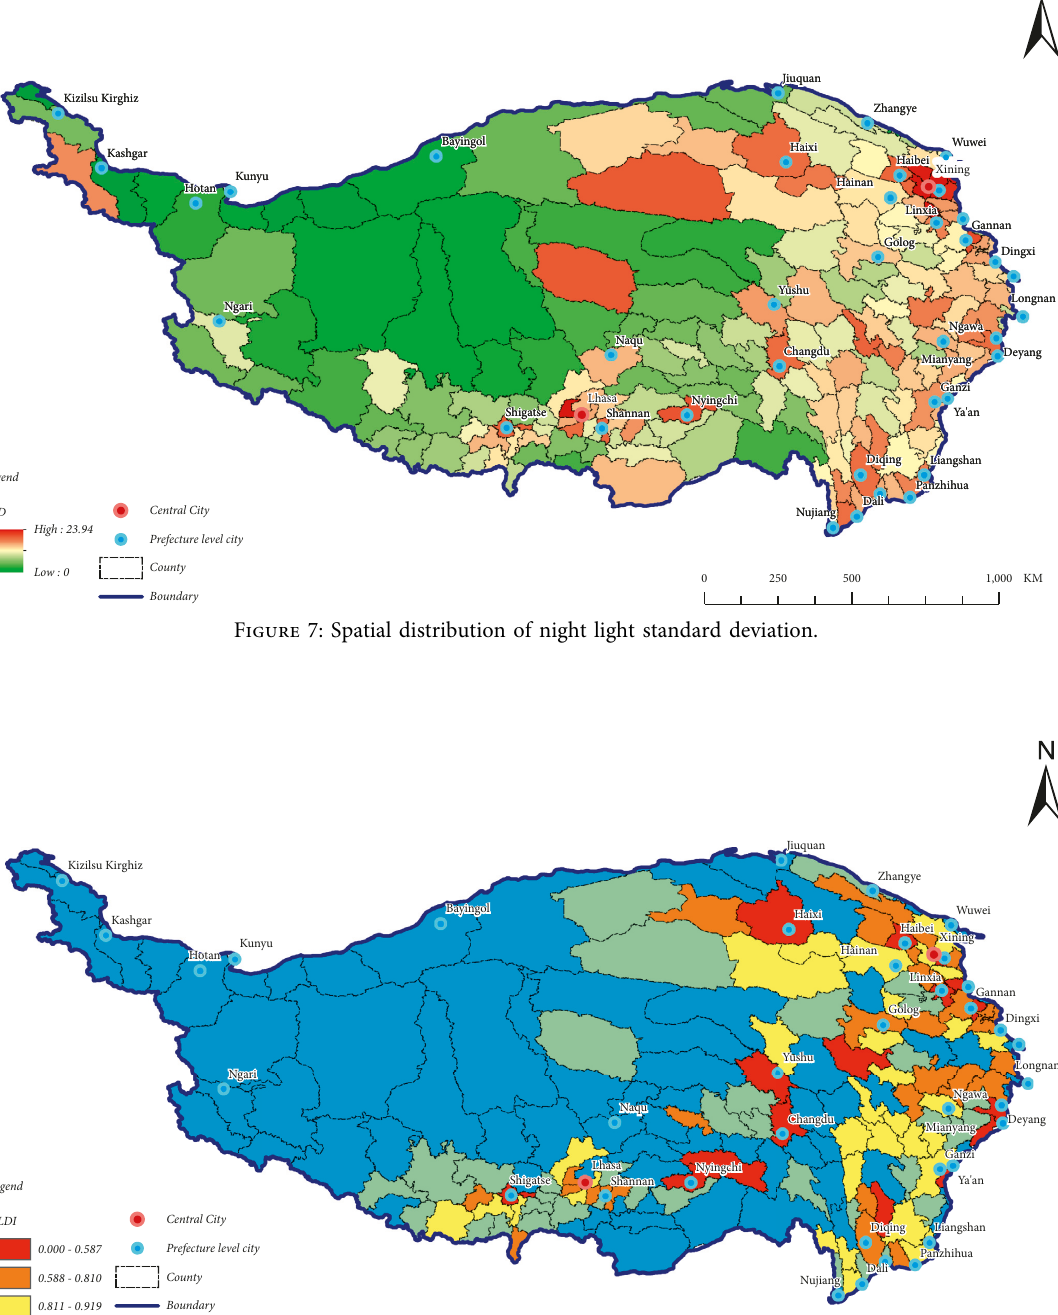
Figure 8: Spatial distribution of NLDI